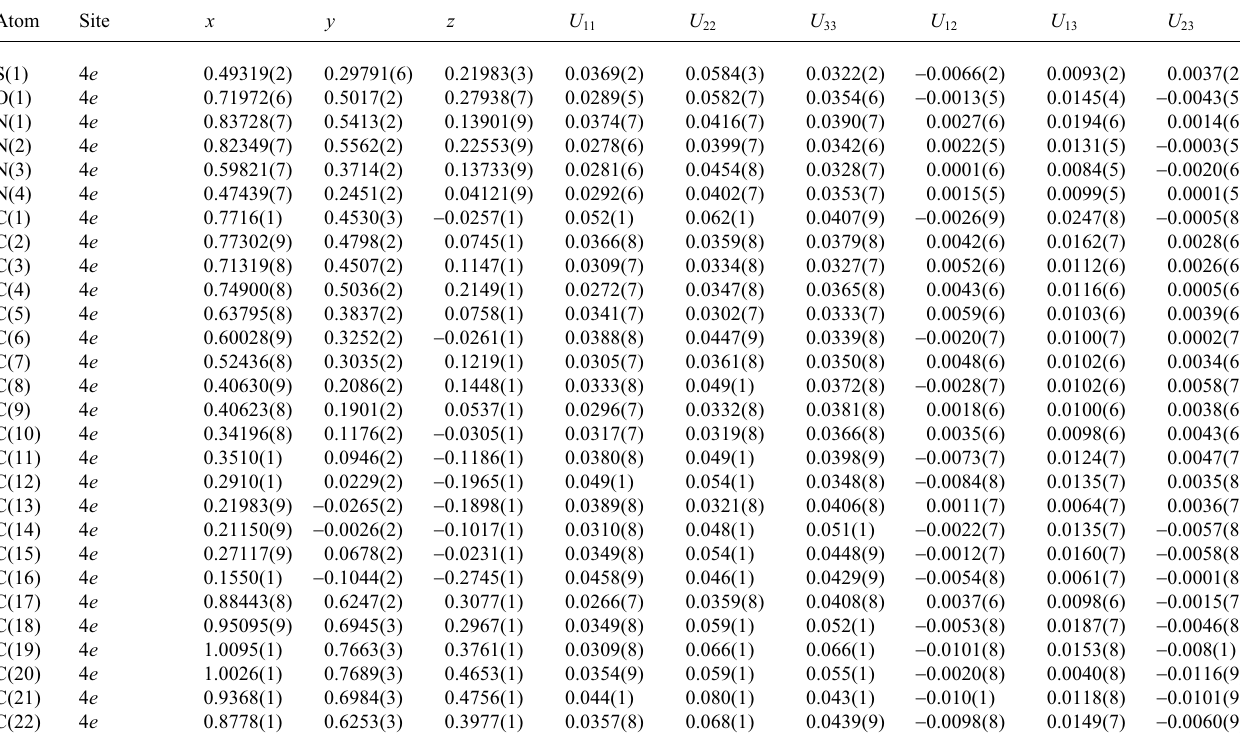
Table 3. Atomic coordinates and displacement parameters (in Å 2 )